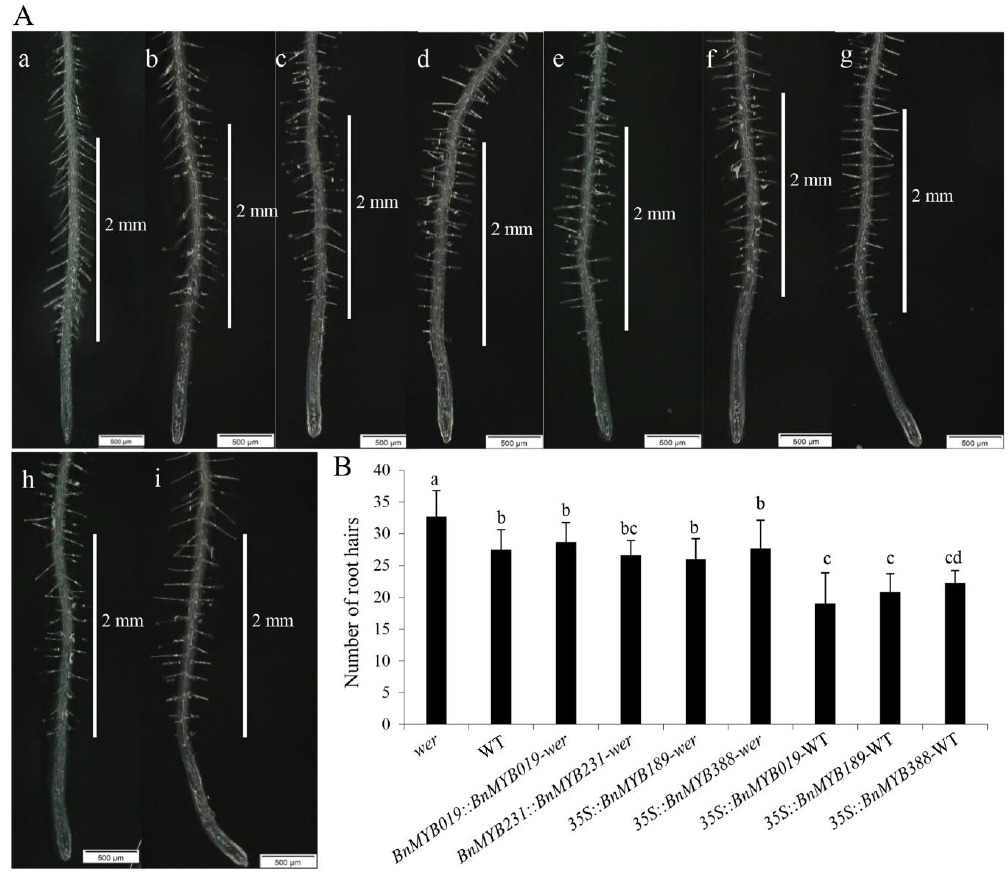
Figure 3. Complementation assay of root hair density in the Arabidopsis thaliana wer mutant background using the four Brassica napus WER -homologous genes BnMYB019 , BnMYB189 , BnMYB231, and BnMYB388 . ( A ) Representative picture showing root hair morphology and density (2 nm) in 7-day-old A. thaliana seedlings of wer mutant ( a ), wild-type (WT) ( b ), and wer mutant plants harboring BnMYB019::BnMYB019 ( c ), wer mutant plants harboring BnMYB0231::BnMYB231 ( d ), wer mutant plants harboring 35S::BnMYB189 ( e ), wer mutant plants harboring 35S::BnMYB388 ( f ), WT plants harboring 35S::BnMYB019 ( g ), WT plants harboring 35S::BnMYB189 , and ( h ) WT plants harboring 35S::BnMYB388 ( i ). ( B ) Root hair density in 7-day-old A. thaliana seedlings of the corresponding lines ( n = 3, 10 plants/genotype/experiment). Different letters indicate significant differences (least significant difference test; p < 0.05).